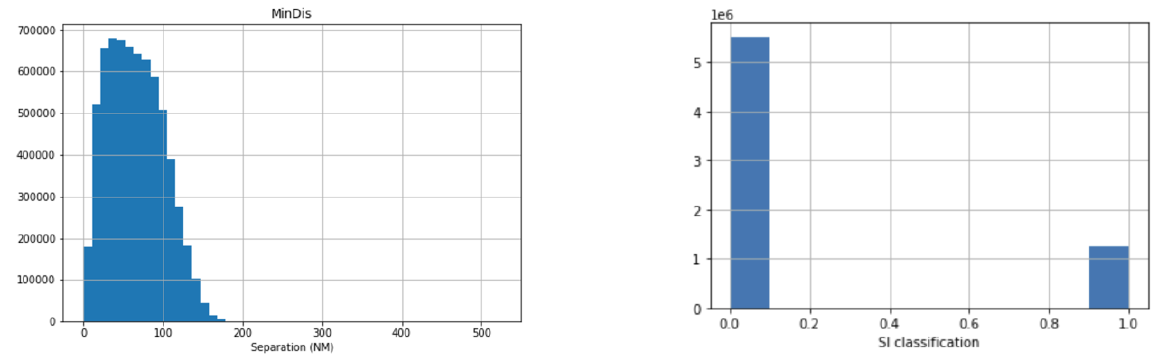
Figure 5. Histograms of the regression and classification